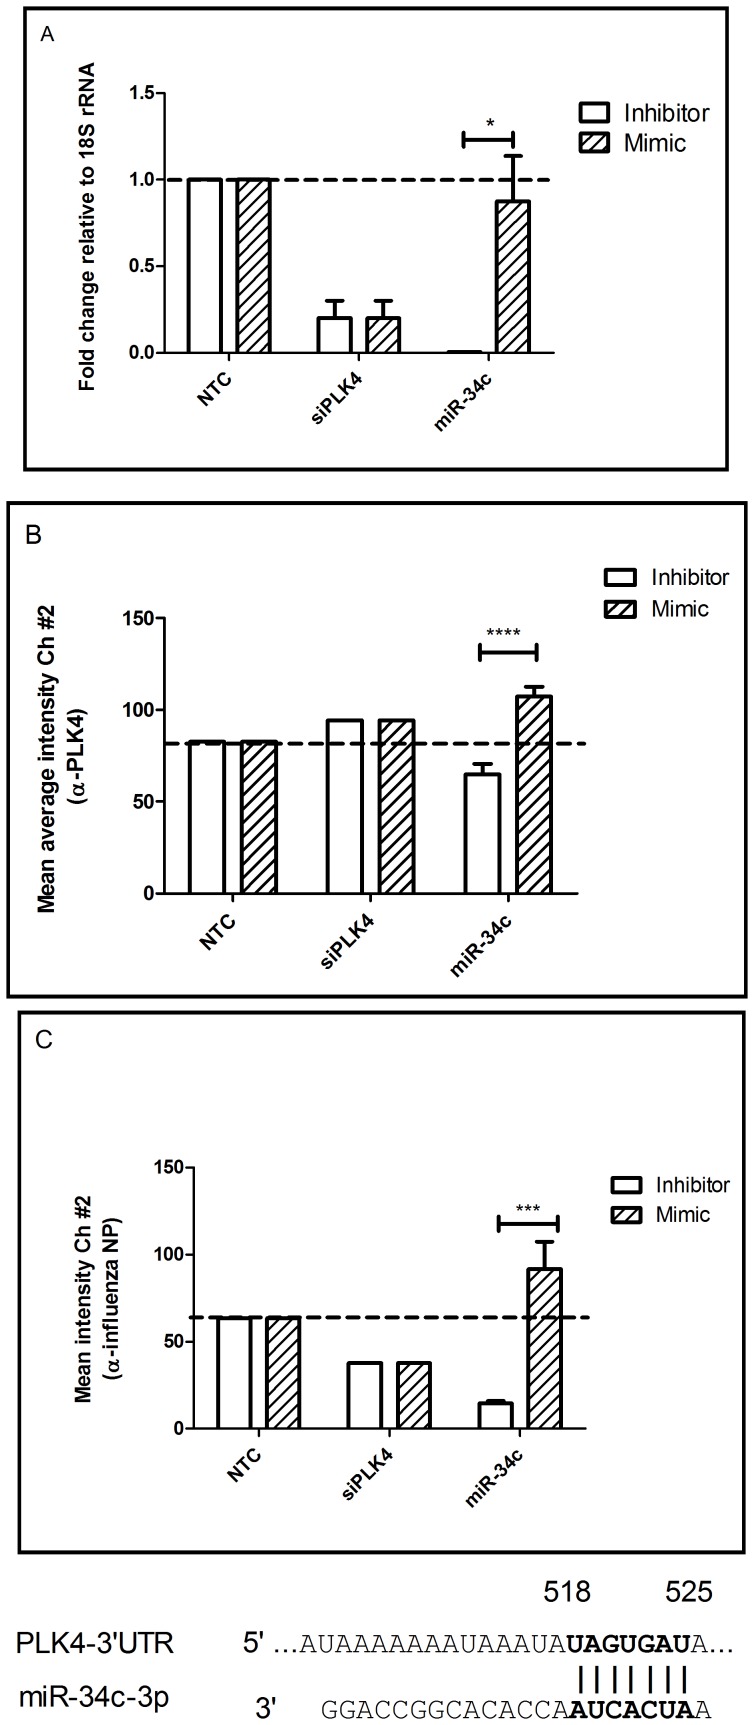
miRNA regulators of PLK4 (A) A549 cells were transfected with 25 nM of miR-34c inhibitor/mimic for 48 hrs followed by RNA extraction and RT-qPCR with PLK4 specific primers.Expression data was normalized to 18S rRNA expression and shown as mean±SEM of independent experiments. *p<0.05 compared to control. (B) A549 cells mock/transfected with miR-34c inhibitor/mimic for 48 hrs were fixed with 4% formaldehyde in PBS and stained for PLK4 protein using biotinylated rabbit anti-PLK4 antibody (Abcam ab71394) and detected with Streptavidin-Alexa488. Cells were analyzed by Arrayscan Cellomics VTI scanner and data analyzed by GraphPad Prism. (C) A549 cells mock/transfected with miR-34c inhibitor/mimic for 48 hrs were infected with A/WSN/33 (MOI = 0.001) for 48 hrs and stained for influenza NP protein using mouse-anti-NP coupled to Alexa-488 and analyzed as above in (B). Data show mean±SEM of two independent experiments. *p<0.05.